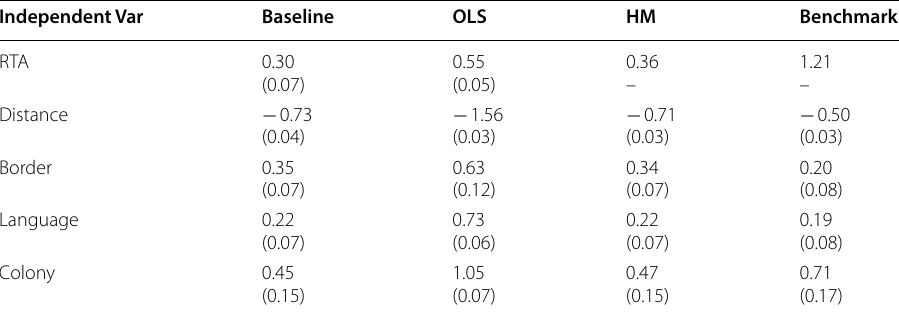
Table 2 Estimated values of trade cost functions